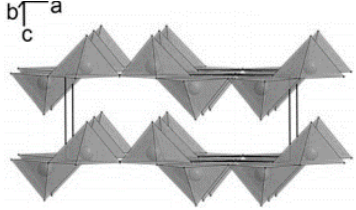
Figure 2. Schematic representation of V 2 O 5 structure.